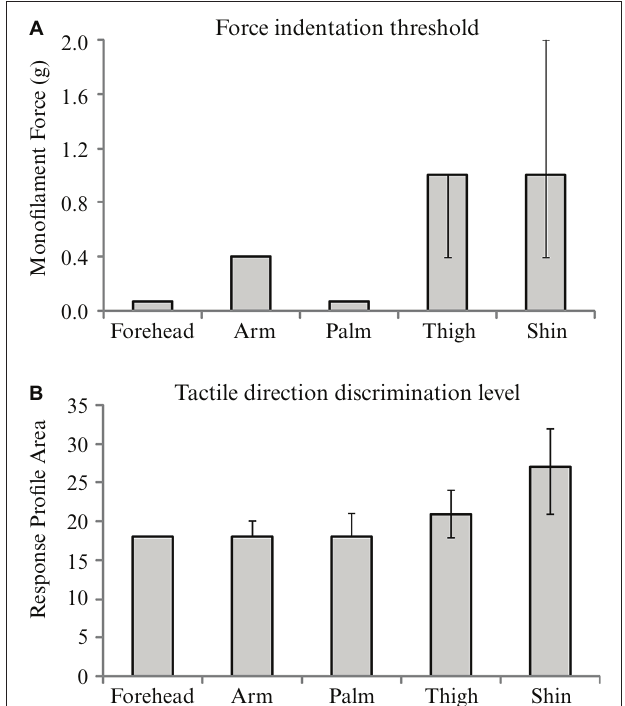
FIGURE 4 | The median values for and tactile sensitivity and discrimination over the skin. Medians are shown for (A) force indentation threshold using monofilaments, and (B) tactile direction discrimination level for each of the five skin sites from the main experiment. Significant effects of skin site were found for both tests; see Results for individual differences between sites. Error bars indicate inter-quartile confidence intervals for the ordinal data; note that there are no inter-quartile confidence bars for the results in Figure 4A forehead, arm and palm and in Figure 4B forehead, due to there being no variation in the ranked middle 50% of ordinal